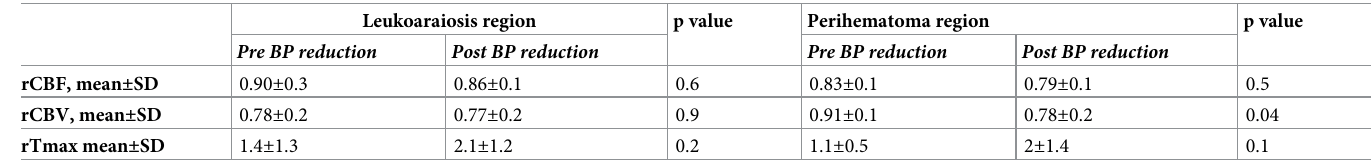
Table 5. Cerebral perfusion pre and post blood pressure reduction in leukoaraiosis areas and perihematoma regions (n = 8). Leukoaraiosis region p value Perihematoma region p value Pre BP reduction Post BP reduction Pre BP reduction Post BP reduction rCBF, mean ±